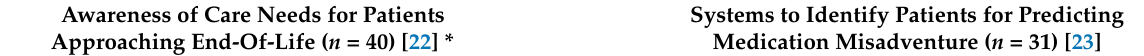
Table 6. Pharmacists’ awareness of care needs for patients approaching end-of-life and indicators for predicting medica- tion